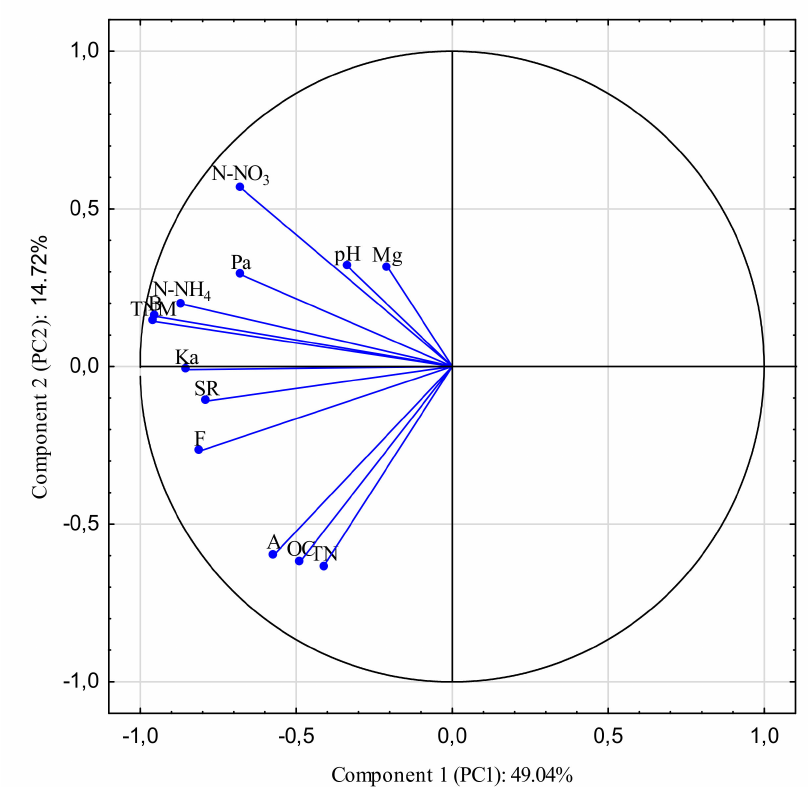
Figure 1. PCA analysis (principal component analysis PC1, PC2) of soil parameters: total number of microorganisms (TNM); bacteria (B); actinobacteria (A); fungi (F); soil respiratory activity (SR); pH in 1 M KCl (pH); organic carbon content (OC); plant-available phosphorus content (Pa), potassium (Ka), magnesium (Mg); total nitrogen content (TN), mineral forms of nitrogen: N-NO 3 and N-NH 4